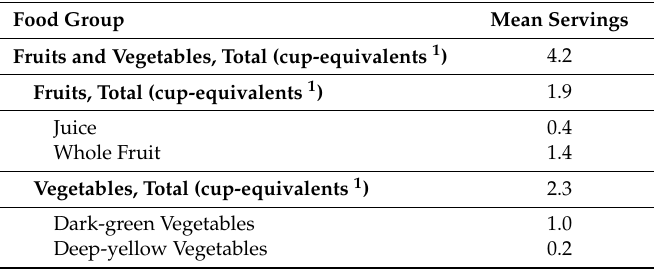
Table 2. Mean food group servings of 1719 kcal (7192 kJ) seven-day low saturated fat Swank